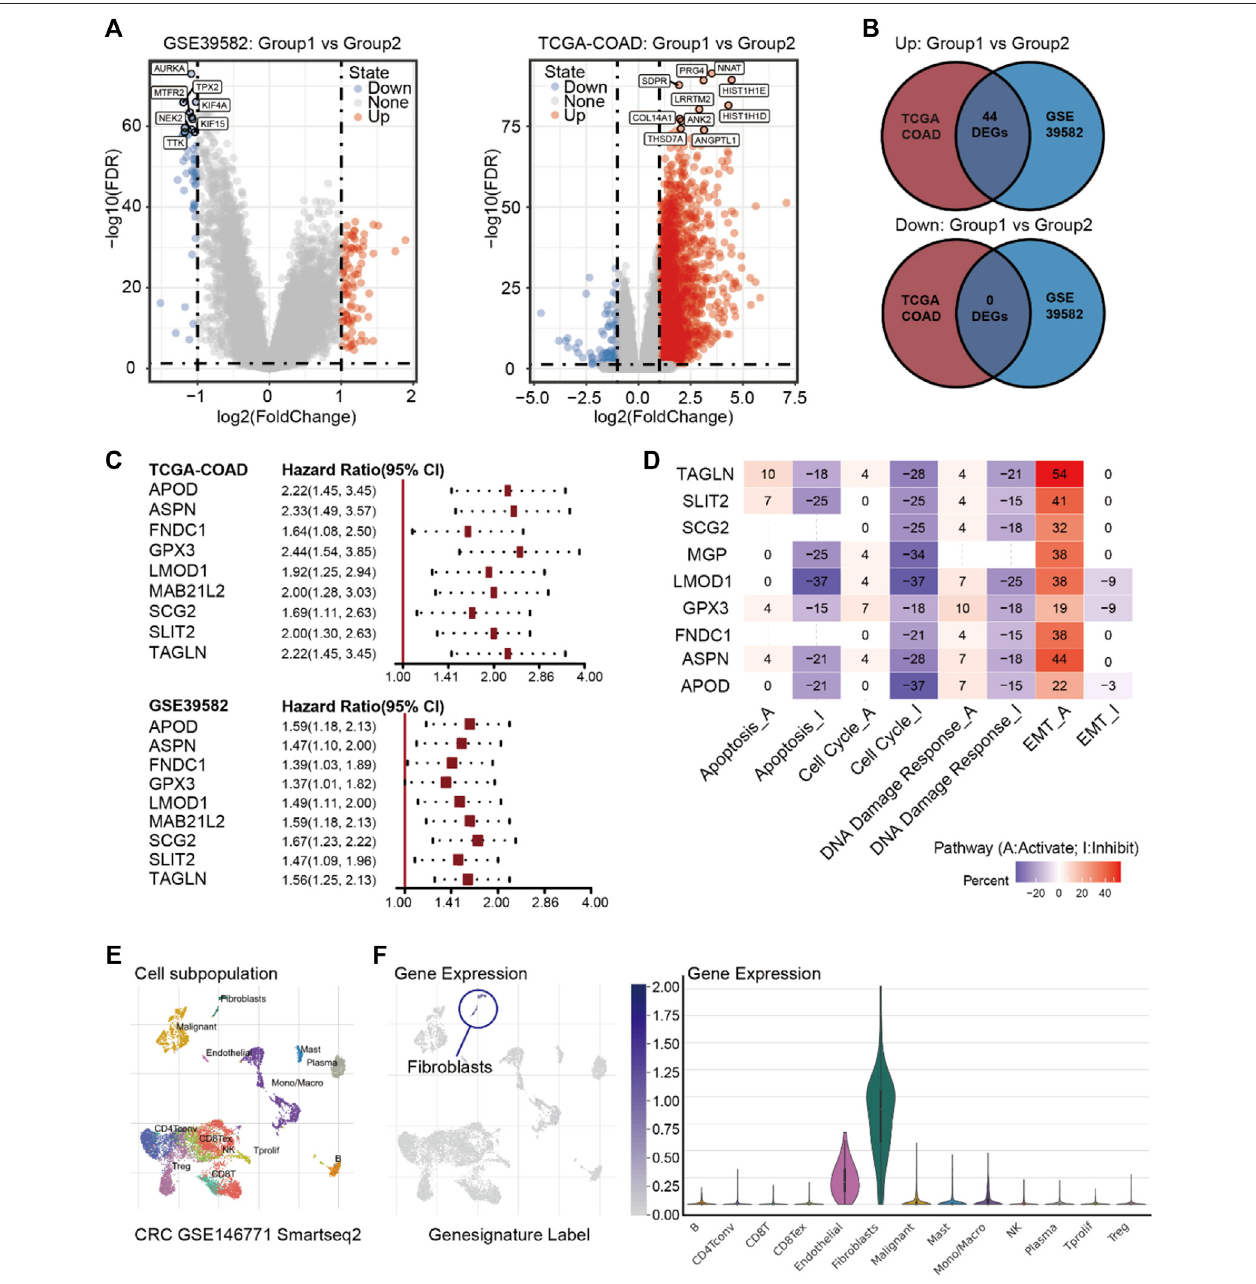
FIGURE 3 | (A) Volcano plot of DEGs between Group 1 and Group 2 in GSE39582 and TCGA-COAD. (B) Intersections of DEGs between TCGA-COAD and GSE39582. (C) Cox proportional hazards regression analyses of nine prognosis-related genes in GSE39582 and TCGA-COAD. (D) Pathway activity of the nine prognosis-related genes. (E) Annotations of cell subpopulations in GSE146771. (F) Expressions of nine prognosis-related genes among cell subpopulations in GSE146771.